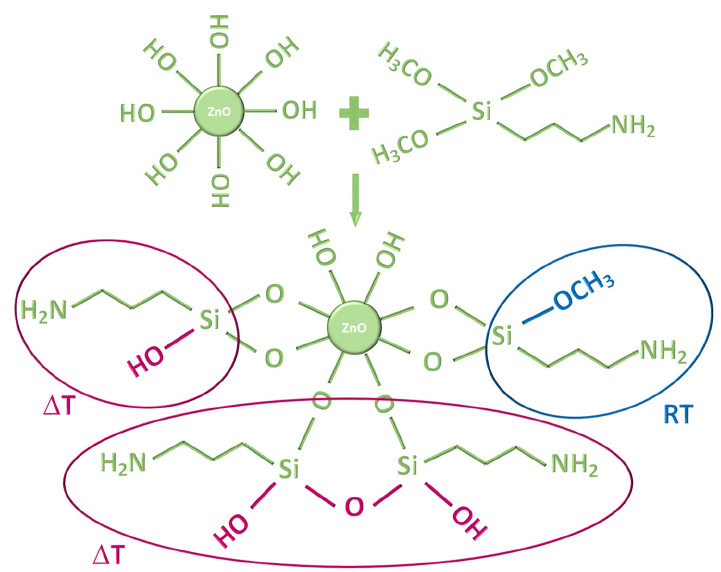
Figure 3. Sketches of ZnO condensation with APTMS. The red oval shapes outline the hydroxylation procedure and the Si-O-Si network formation at higher temperatures (reflux). In the blue circle, the persistence of -OCH 3 moiety upon RT synthesis is outlined.